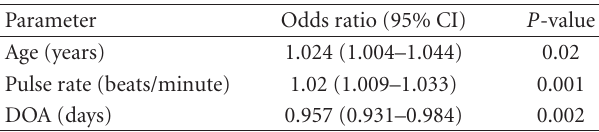
Table 4: Multivariable-adjusted odds ratios for total